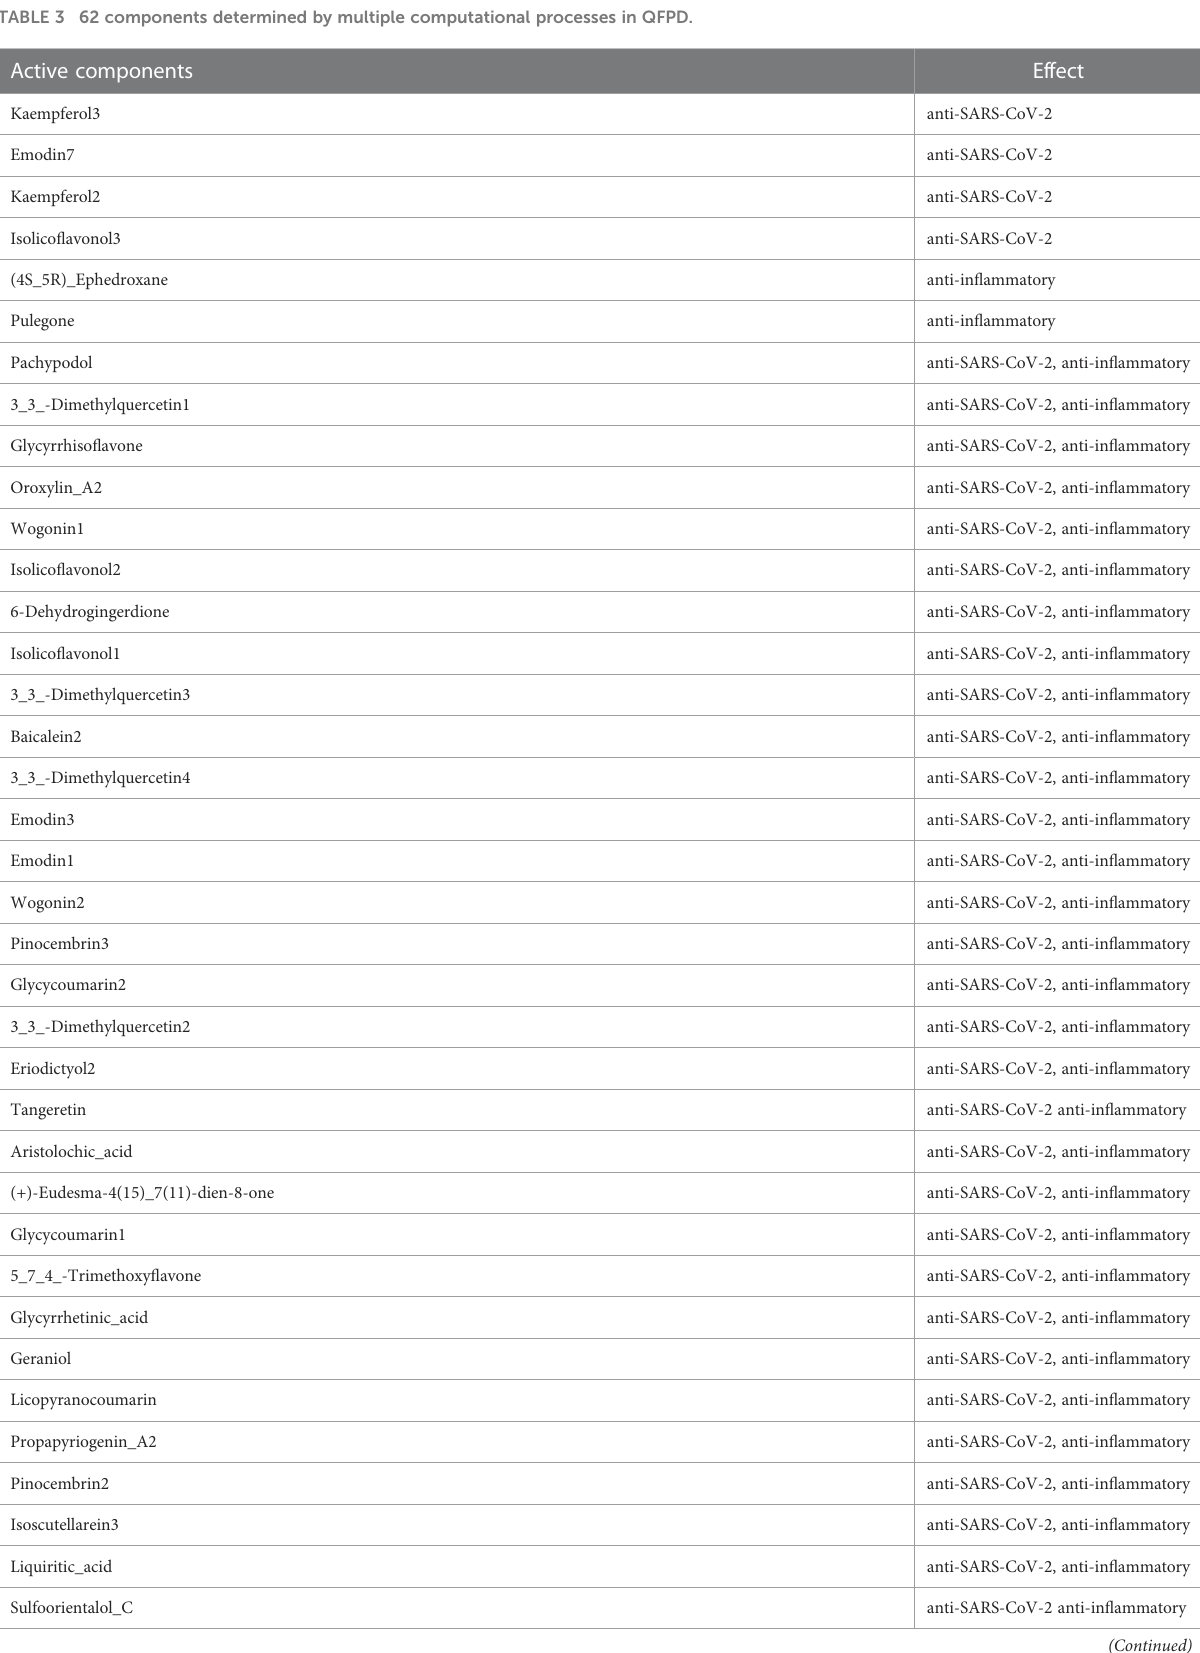
TABLE 3 62 components determined by multiple computational processes in